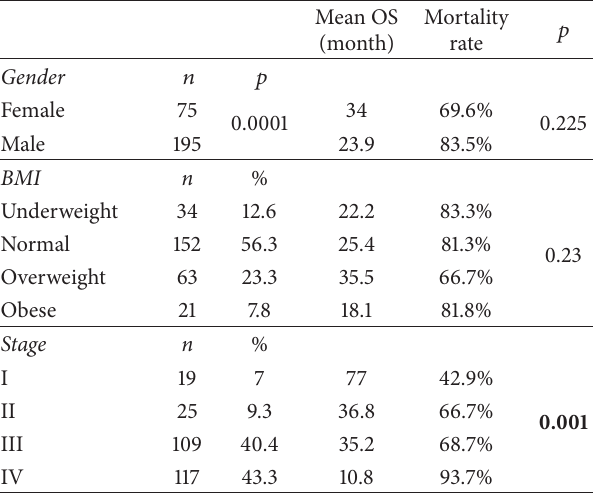
Table 1: Clinicopathological features of all patients with respect to gender, BMI (body mass index), and stage of